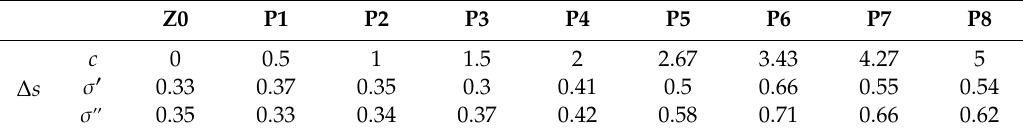
Figure 11. The membership function of the expected deceleration.